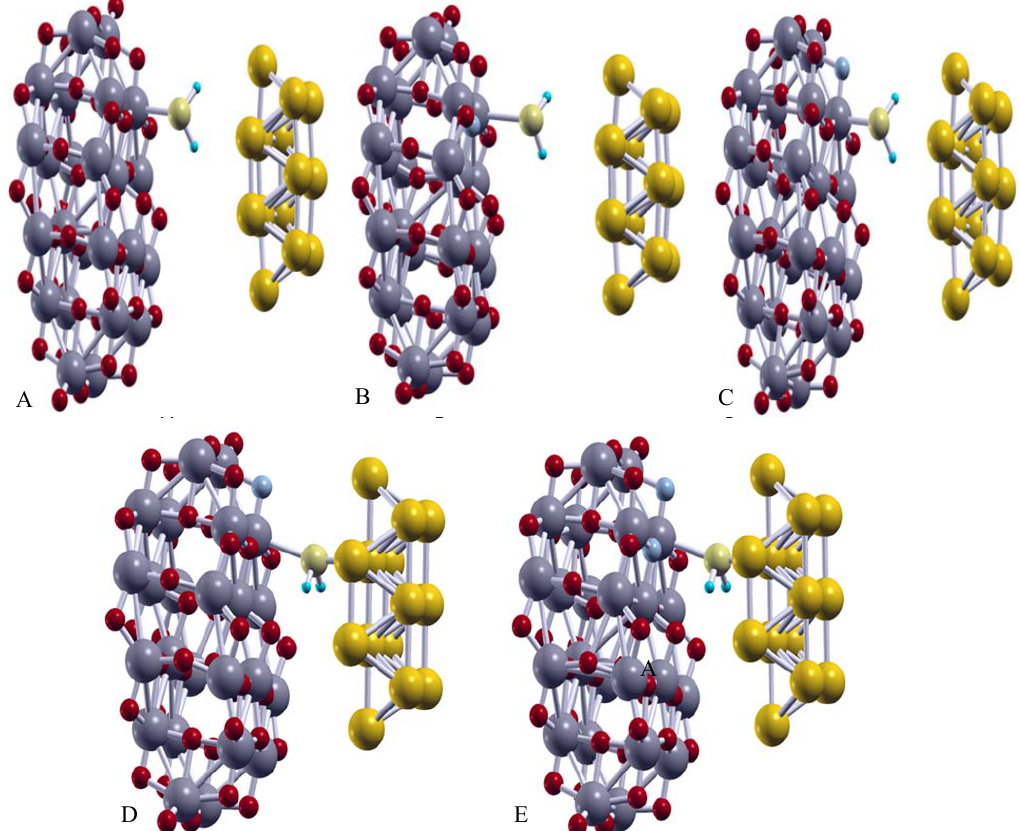
Fig. 3. Optimized geometry configurations of the interaction of H